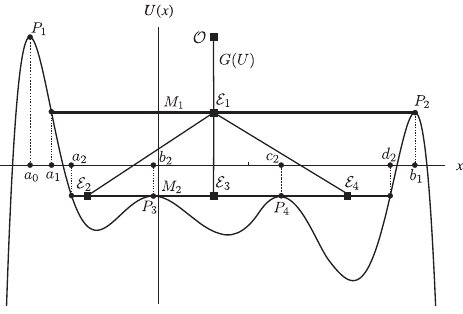
Figure 1. A Morse potential U has seven critical points and satisfies (B4). The function U has four CS E 1 = [( a 1 ,M 1 ) , ( b 1 ,M 1 )], E 2 = [( a 2 ,M 2 ) , ( b 2 ,M 2 )], E 3 = [( b 2 ,M 2 ) , ( c 2 ,M 2 )], and E 4 = [( c 2 ,M 2 ) , ( d 2 ,M 2 )], which are nodes of the associated rooted tree G ( U